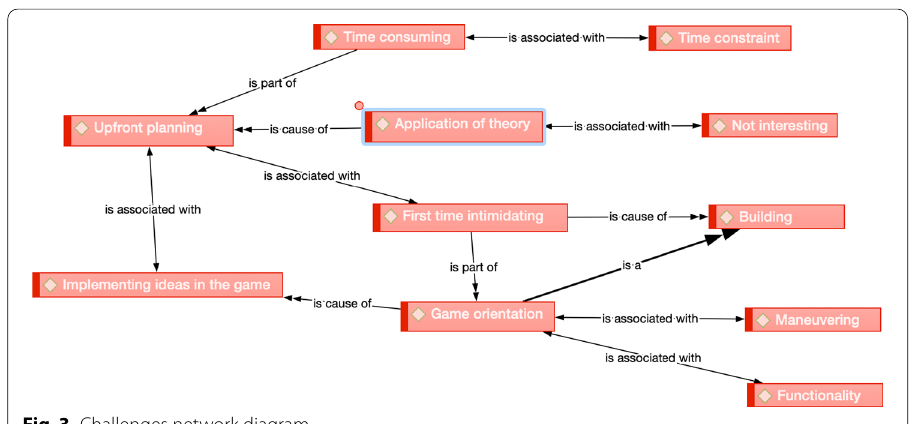
Fig. 3 Challenges network